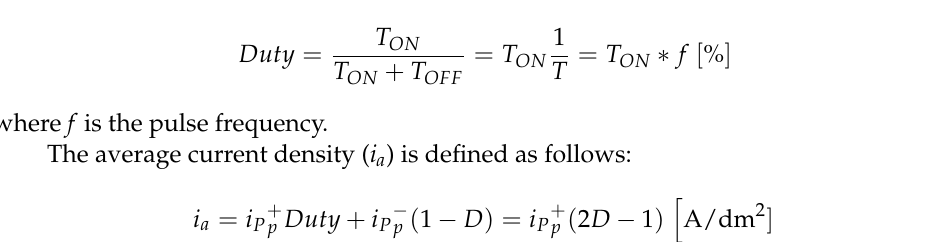
Table 5. Control factors and their levels.